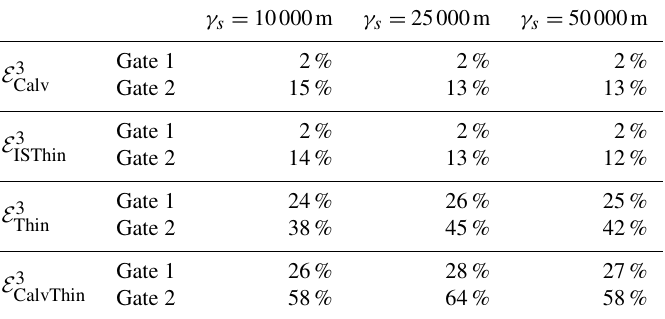
Table D1. Sensitivity of the relative flux changes in the E 3 ∗ experiments (see Fig. 3) with respect to the choice of regularization multiplier γ s . The optimal value, γ s = 25000 m, used throughout this study was based on the L curve presented in Fig.